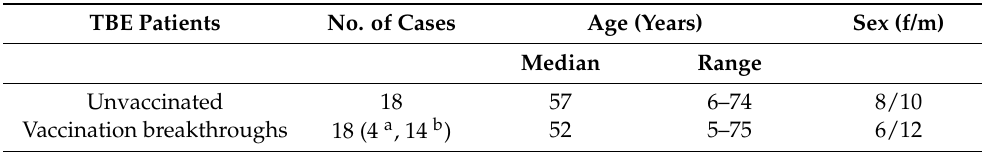
Table 1. Characteristics of TBE patients with and without prior vaccination.